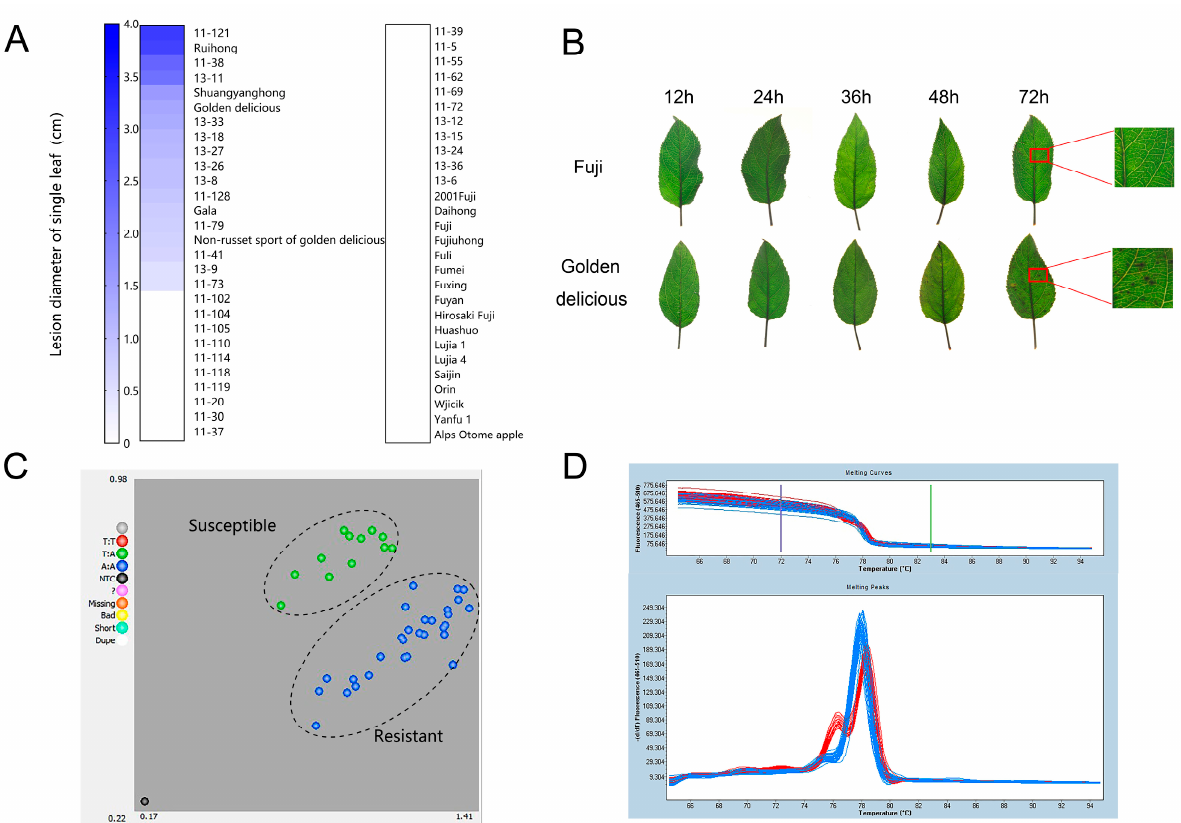
Figure 1. Resistance identification of different apple cultivars to GLS and genotyping of apple cultivars (lines) with different resistance levels using SNP 7309212 . ( A ) Lesion diameter on the single leaf (cm) of apple. A total of 56 cultivars (lines) were evaluated, including 34 F1 hybrid populations from ‘Fuji’ × ‘Golden delicious’ and 22 cultivars. ( B ) Symptoms of disease-resistant cultivar ‘Fuji’ and susceptible cultivar ‘Golden Delicious’ after inoculated with C. fructicola. ( C ) Distribution of SNP 7309212 genotype by KASP analysis. Red solid circles indicate homozygous TT, blue ones represent homozygous AA, and green are heterozygous AT. ( D ) SNP 7309212 genotype assay of apple cultivars (lines) with different disease resistance using HRM technique marked. The blue melting curves indicate resistant apples cultivars (lines), and red melting curves represent susceptible cultivars (lines).